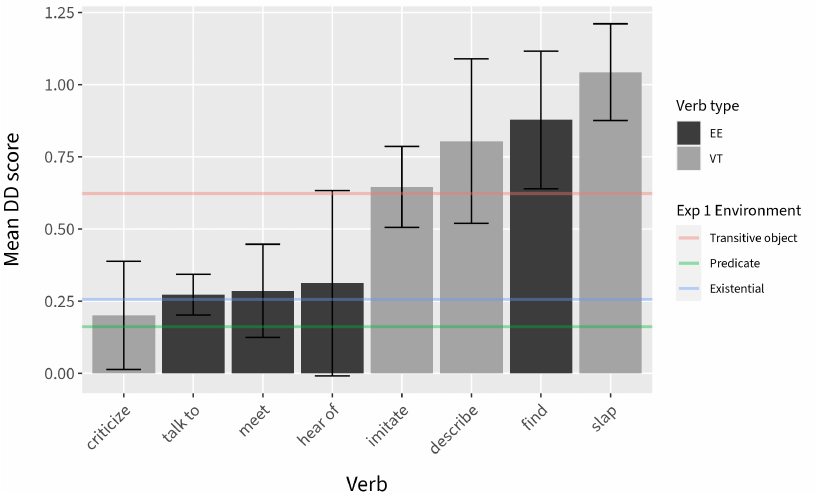
Figure 7. DD scores (calculated from z-scored ratings) by verb for Experiment 2 with DD scores for Experiment 1 environments overlaid as horizontal lines. Error bars represent the standard error over DD scores calculated by item. Summary statistics are based on five to six DD scores calculated for each verb. See z-scored ratings by item in Appendix